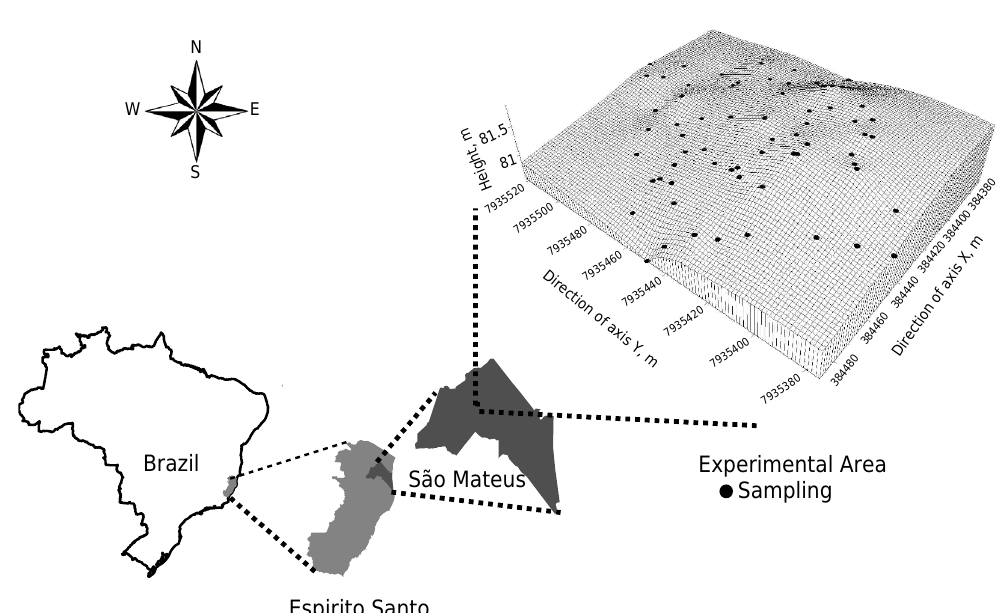
Figure 1. Location of the study area and sampling points used in the